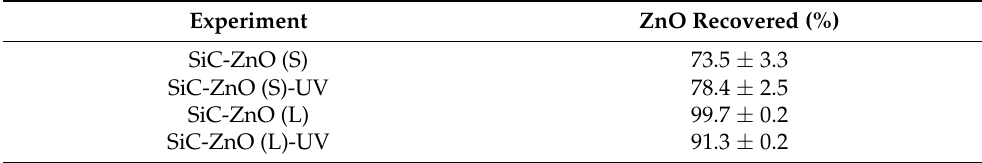
Table 2. Percentage of catalyst recovered after five filtration assays.